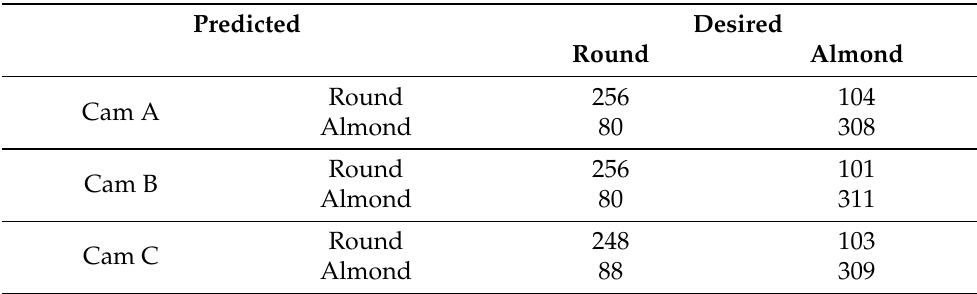
Table A5. Confusion matrices depict eye shape attributes prediction in each webcam versus the ground